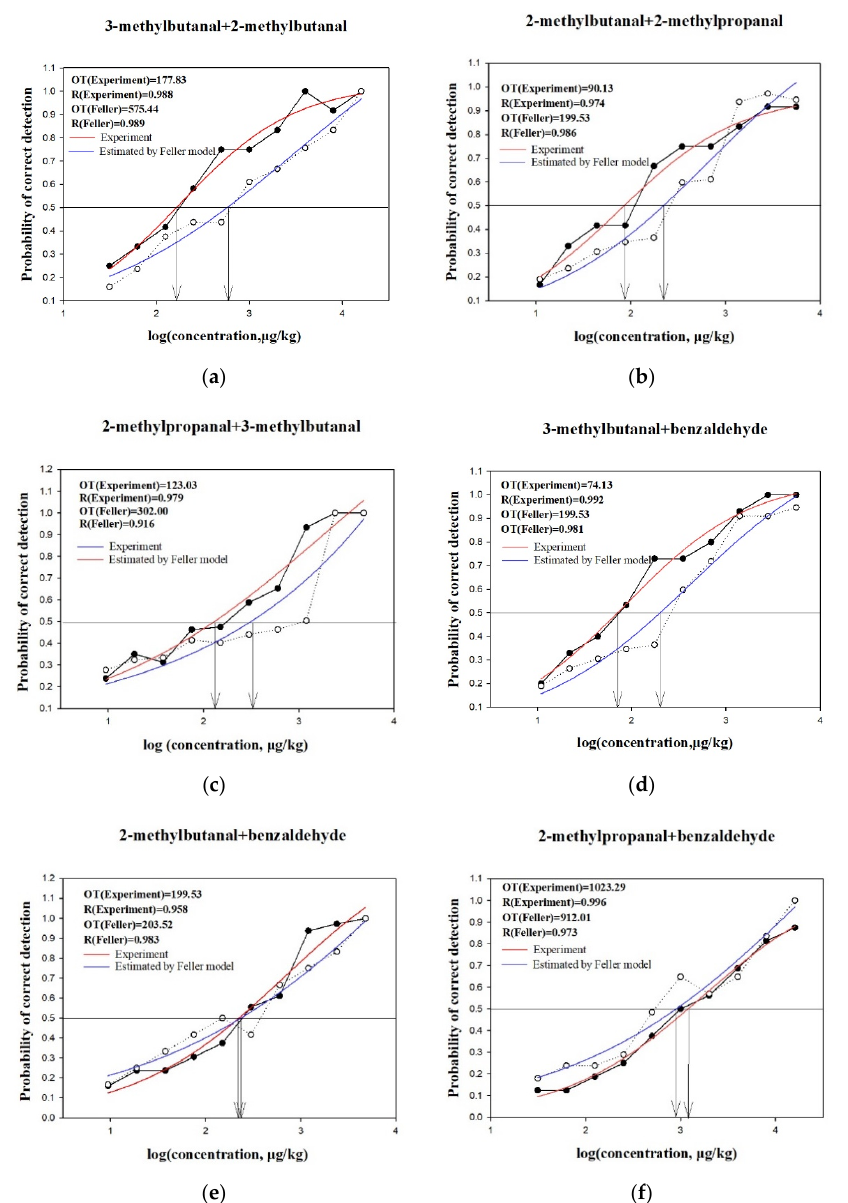
Figure 2. Perceptual interactions among six pairs of binary mixtures as determined using Feller’s additive model. ( a ) 3-Methylbutanal and 2-methylbutanal, ( b ) 2-methylbutanal and 2-methylpropanal, ( c ) 2-methylpropanal and 3-methylbutanal, ( d ) 3-methylbutanal and benzaldehyde, ( e ) 2-methylbutanal and benzaldehyde, ( f ) 2-methylpropanal and benzaldehyde. The horizontal line indicates that the correct detection probability is 50%. The two arrows represent the corresponding log (concentration) values under the correct detection probability of 50%. The solid dots represent the detection probability obtained by the experiments, and the empty dots represent the detection probability obtained by the Feller model. OT, olfactory threshold. R—Feller’s additive model fitting result.